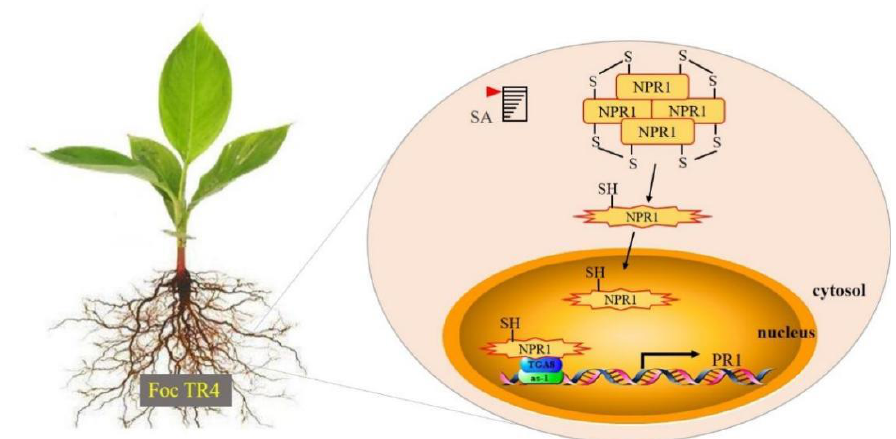
Figure 7. Working model of MaTGA8 regulates bananas to improve disease. Bananas are invaded by Foc TR4, SA accumulates in the plant, and NPR1(MaNPR4/MaNPR11) is reduced from an oligomeric state to a monomeric state and is then translocated to the nucleus, interacts with TGA factors, and promotes the expression of PR genes.